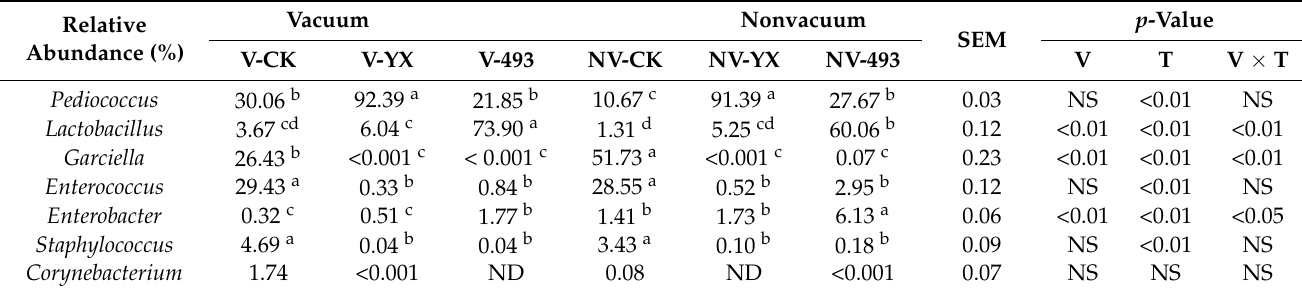
Table 4. Effects of vacuum treatment, inoculants and their interactions on the relative abundance of genera at 90 days. Relative